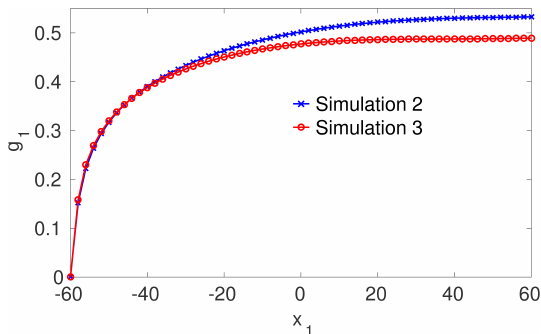
Figure 4. Profiles of g 1 = [[ u 1 ]] along x 1 at x 3 = 0 for simulations 2 and 3.